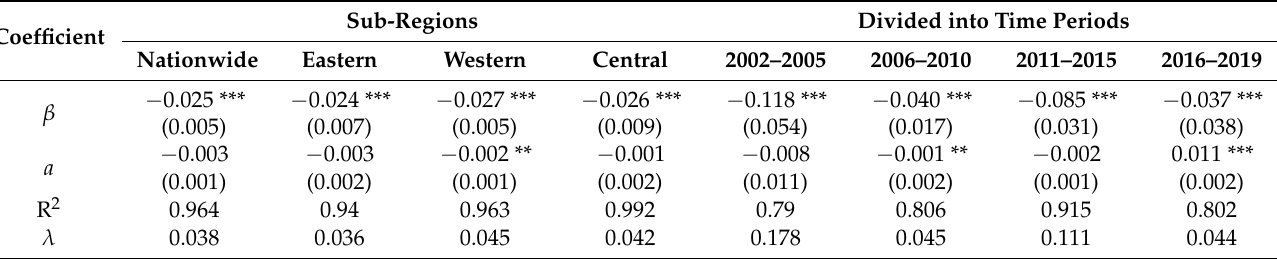
Table 2. Table of absolute β convergence